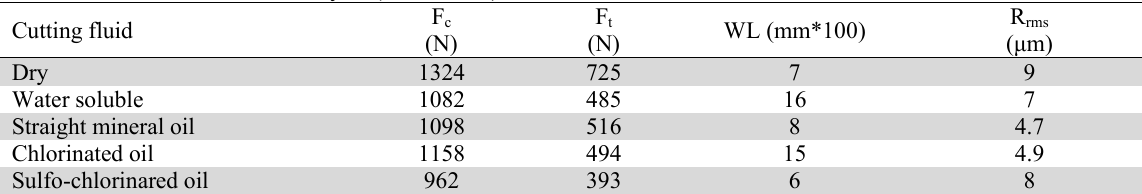
Decision matrix for case study 3 (Rao 2007) Cutting fluid